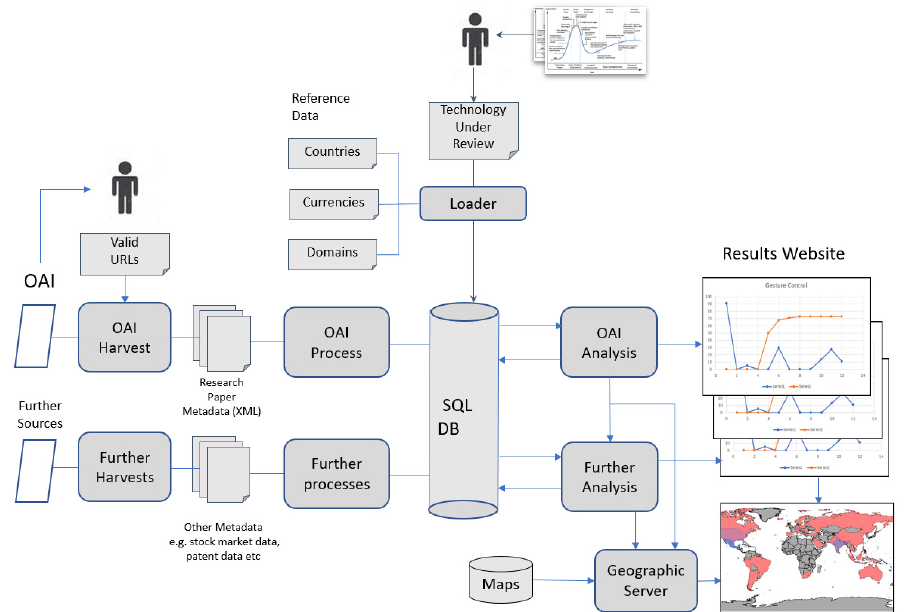
Figure 5. The experiment Analytic Framework.